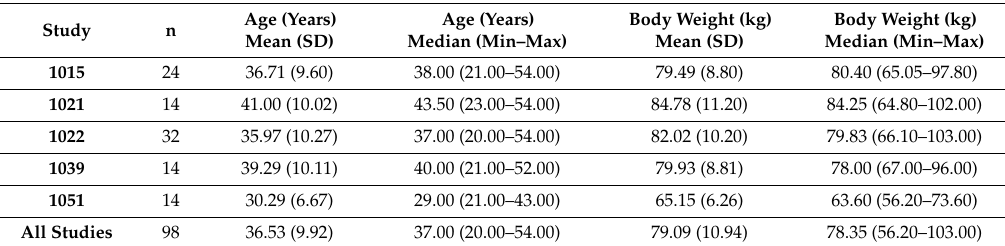
Table 2. Demographic Characteristics for the Pooled Dataset of Dacomitinib Studies.